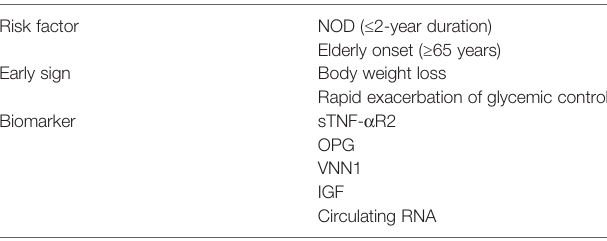
TABLE 1 | Risk factors, early signs, and biomarkers for pancreatic cancer in patients with type 2 diabetes mellitus. Risk